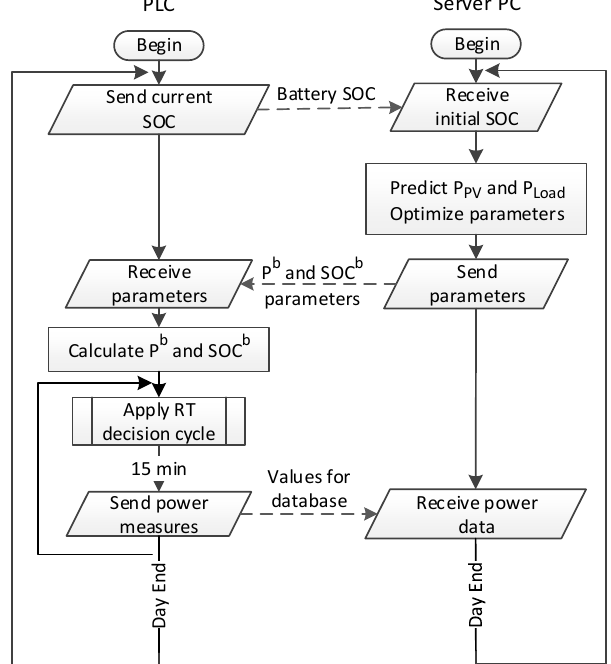
Figure 6. Combined flow chart of the programmable logic controller (PLC) and Server PC (personal computer) duties.